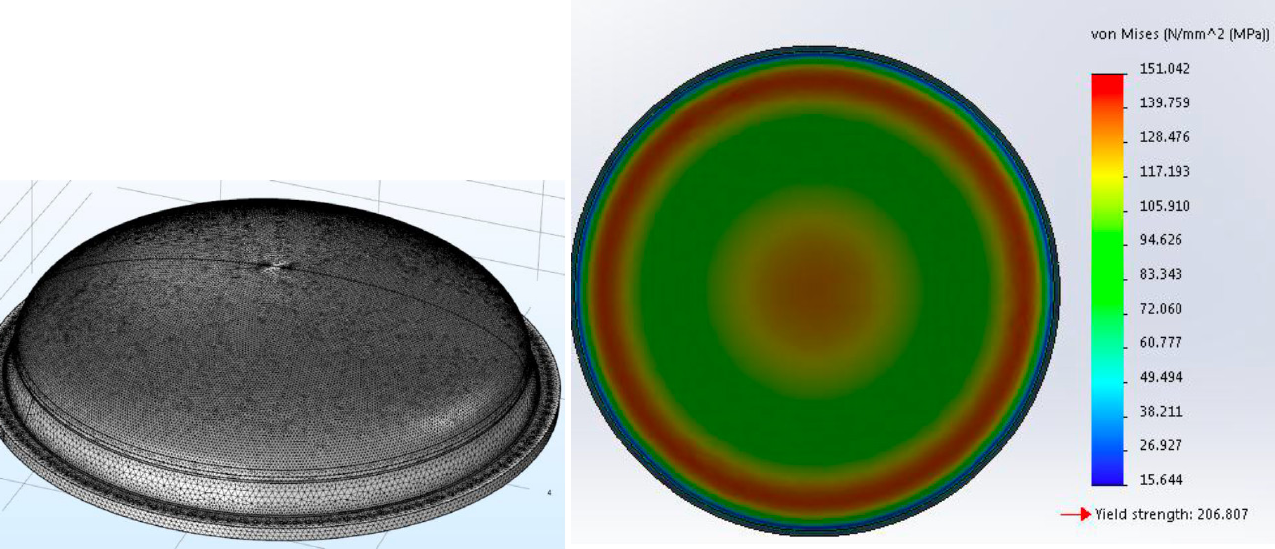
Figure 48. FEA for pressure vessel heads. ( Left ): meshing of stainless steel elliptical heads in comsol multiphysics. ( Right ): stress analysis—maximum von Mises stress 151 MPa is shown (allowable limit is 180